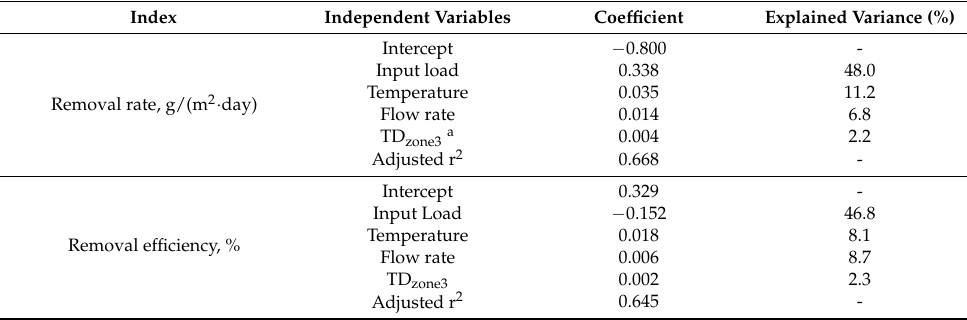
Table 2. Multiple linear regression of nitrate as the nitrogen (NO 3 -N) removal rate and efficiency with nitrate load, temperature, flow rate, and thickness and time duration of the redox zone (TD zone ). Level of significance ( p <